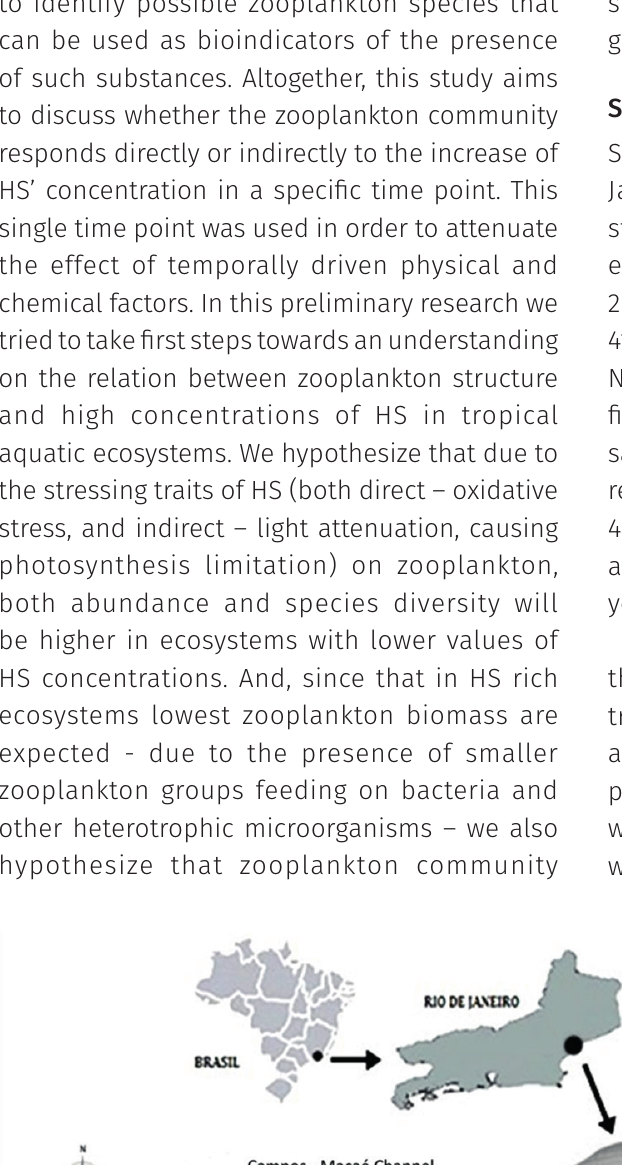
Figure 1. Representative map of the location of sampling environments studied along the humic gradient. CA= Cabiúnas; PA= Paulista; PI= Pitanga; BE= Bezerra; CO= Comprida; AB= Amarra-Boi and AT= Atoleiro. Image modifi ed from: Renault,